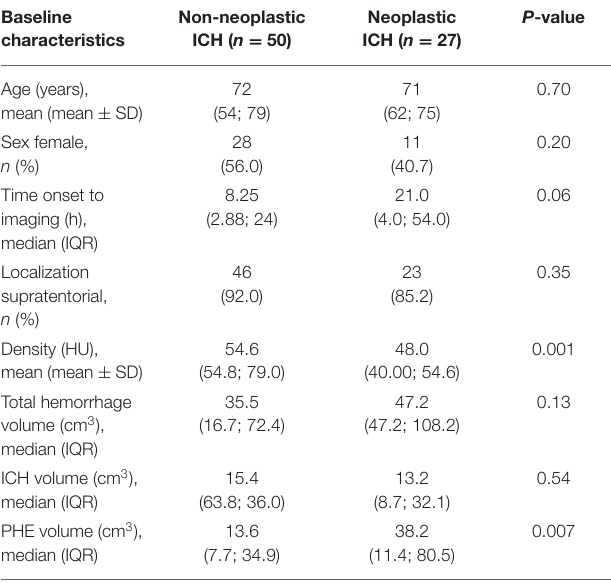
TABLE 1 | Demographic data of study population. Baseline